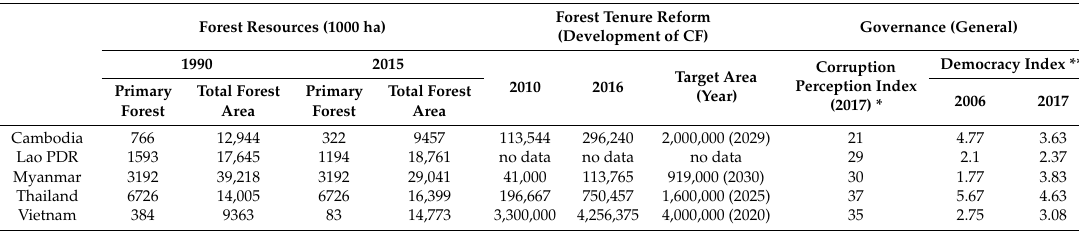
Table 1. Forest cover and forest cover change, development of community forestry, and indicators of governance in the GMS